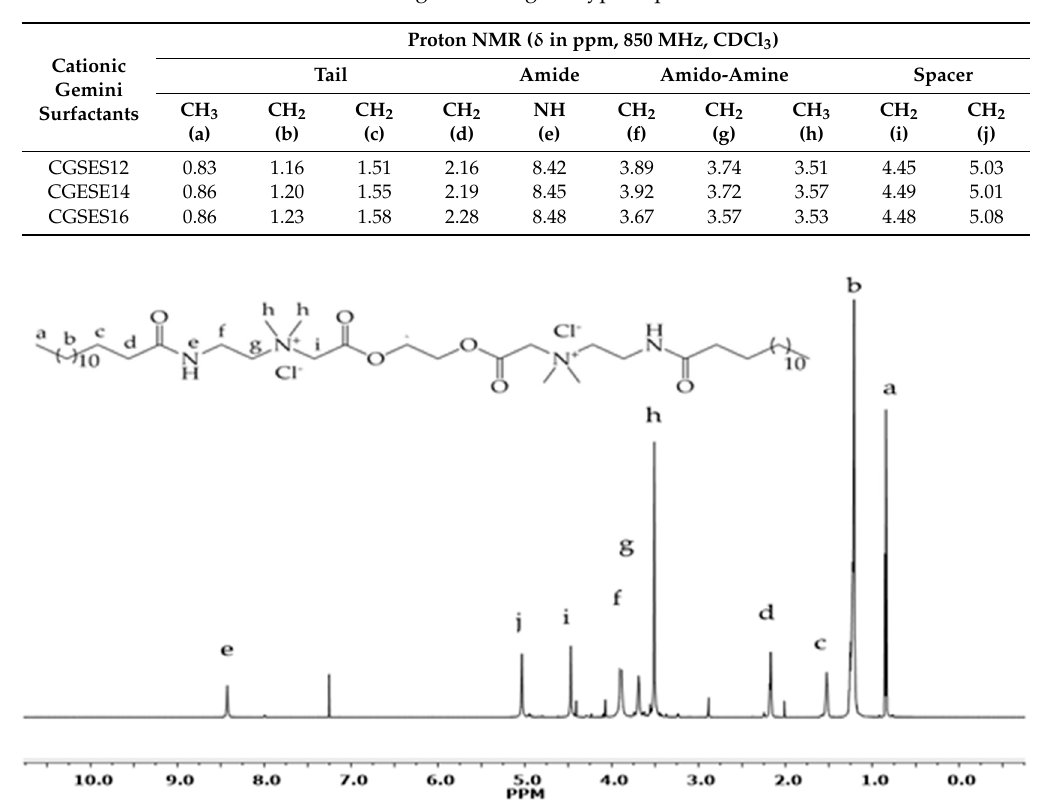
Table 2. 1 H NMR reading describing the type of proton in CGSES12-16.